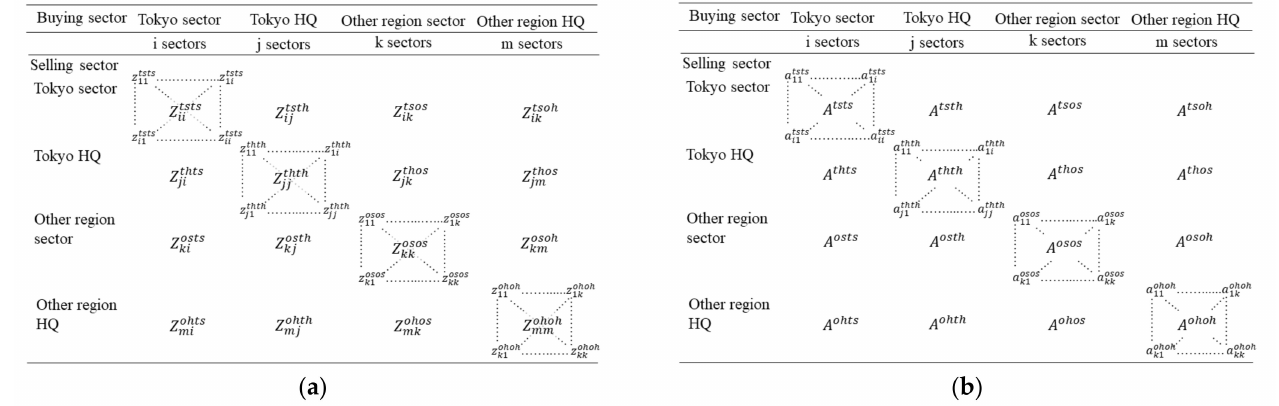
Figure 4. ( a ) Intermediate sectors of the study and ( b ) coefficient matrix of the model.